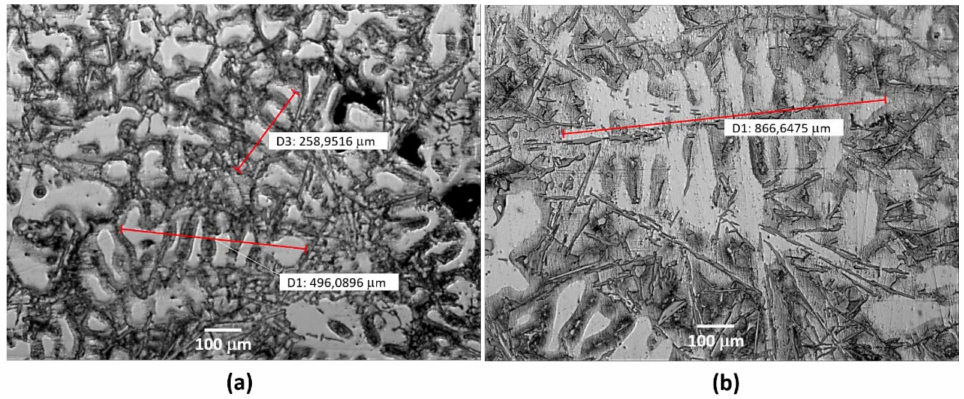
Figure 6. OM micrographs used to evaluate the SDAS ( a ) dendrites solidified in sand mold, and ( b ) dendrites solidified in binder jetting mold. Table 3. Cooling rates obtained from Equation (1) and the SDAS values. Binder Jetting Sand Casting Parameters